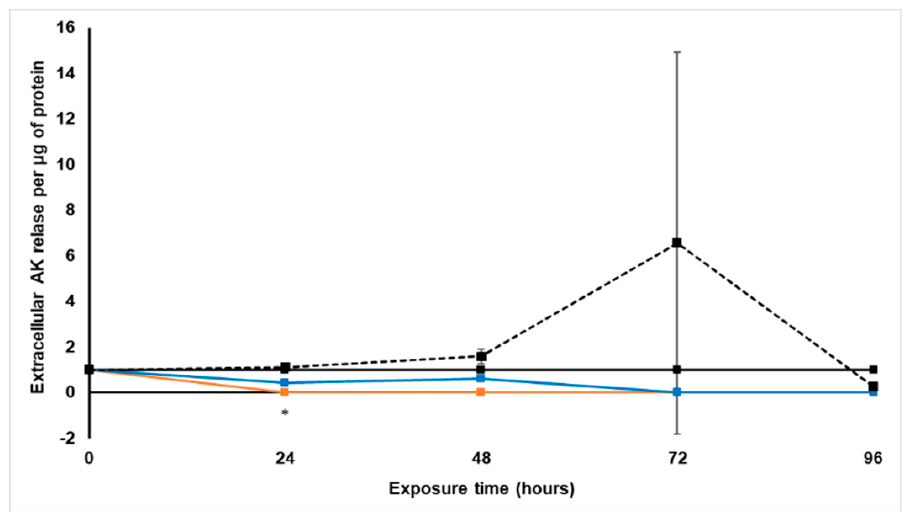
Figure 3. Normalized intracellular adenosine triphosphate content per soluble protein (µM·µg − 1 ) following exposure of the sodium alginate encapsulated LS180 mini-tumor model to Sutherlandia frutescens aqueous extract and paclitaxel. The solid black line represents the untreated control, the black dashed line represents paclitaxel [IC 50 ], the orange line represents S. frutescens [IC 50 ] and the blue line S. frutescens [IC 50 ]/2. All data were normalized to the untreated control group (error bars = standard deviation; n = 3 for S. frutescens [IC 50 ]/2; n = 6 for S. frutescens [IC 50 ] and paclitaxel [IC 50 ]; * = statistically significant, p < 0.05 (one-way ANOVA followed by the Dunnett post-hoc test). 2.3.3. Extracellular Adenylate Kinase Content The extracellular AK levels per protein content were determined with the ToxiLight ® luminescence BioAssay every 24 h during treatment with S. frutescens [IC 50 ]/2, S. frutescens [IC 50 ] and paclitaxel [IC 50 ] for 96 h. These AK levels were then expressed relative to the untreated control, as presented in Figure 4.